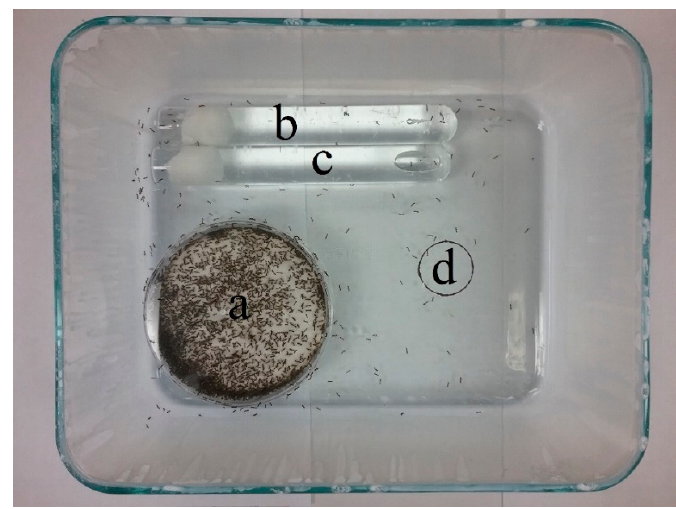
Figure 1. Experimental colonies consisted of a nesting chamber ( a ) filled with multiple queens, thousands of workers, and grams of brood, and tubes filled with water or 20% sucrose water ( b ) and ( c ). Intact live or dead pupae (Section 2.3) or paper wicks containing a methanol or hexane extract (Section 2.4) were placed in the center of a 30 mm diameter circle ( d ).